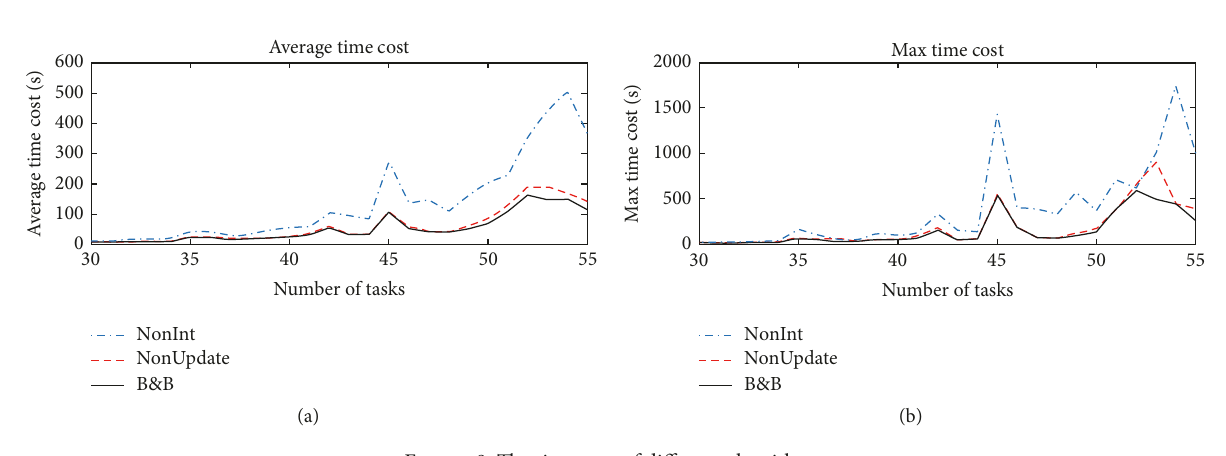
Figure 8: The time cost of different